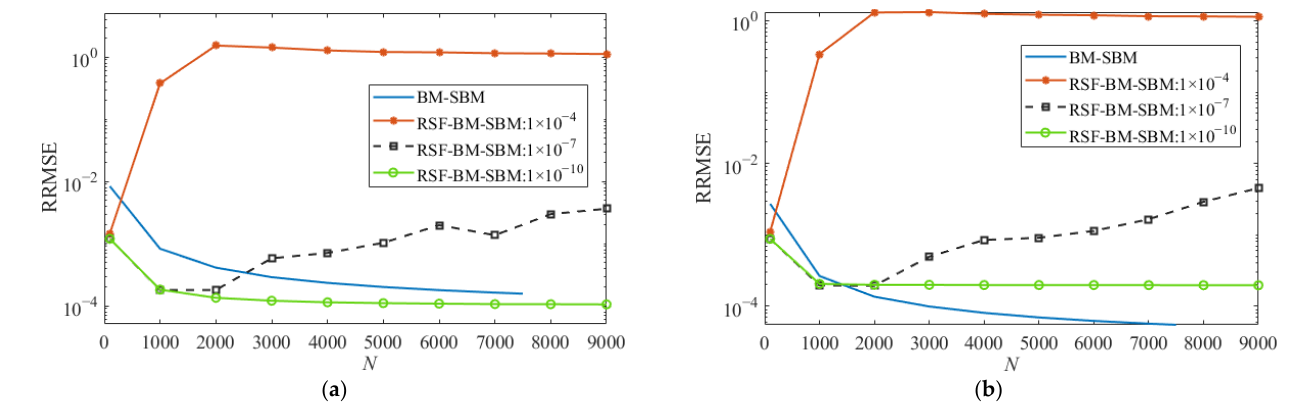
Figure 2. The RRMSEs of the RSF ‐ BM ‐ SBM and conventional BM ‐ SBM: ( a ) real part; ( b ) imaginary part.